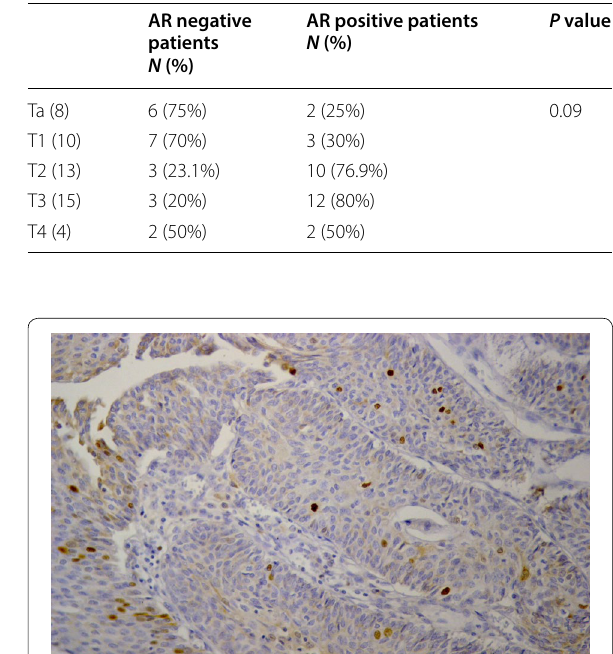
Table 3 Correlation between AR expression and pT stage in the studied urothelial bladder carcinoma patients